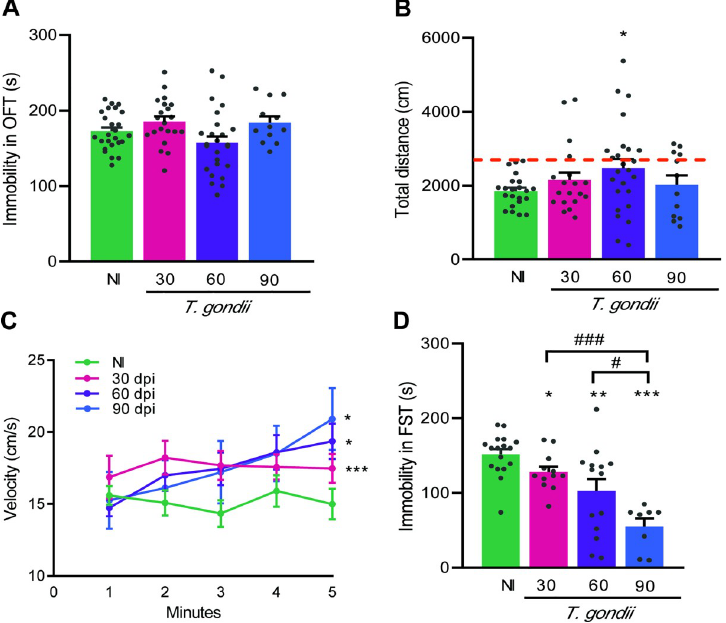
Fig 5. Hyperactive behavior is observed in chronically Toxoplasma gondii -infected C57BL/6 mice. To determine hyperactivity, we evaluated the time spent immobile, the distance and the speed of travel in OFT, and the activity in FST. ( A ) Infected mice did not show differences in immobility time when in the OFT. ( B ) At 60 dpi, mice showed increased distance traveled in OFT. At 30 (18%) and 90 (21%) dpi only a reduced percentage of mice showed increase in the distance traveled. Red dot line shows mean distance of NI group + 2 standard deviation. ( C ) The walk velocity in OFT was increased as infection progressed. ( D ) In FST, immobility time decreased as infection progressed. Each experimental group consisted of 4–6 NI mice and 8–15 T . gondii -infected mice. Each circle represents an individual mouse. Data are expressed as means ± SEM, and were analyzed using t- Student test ( A-C ) and the Mann-Whitney test ( D ). � , p < 0.05, �� , p < 0.01. ��� , p < 0.001, comparing T . gondii- infected and NI